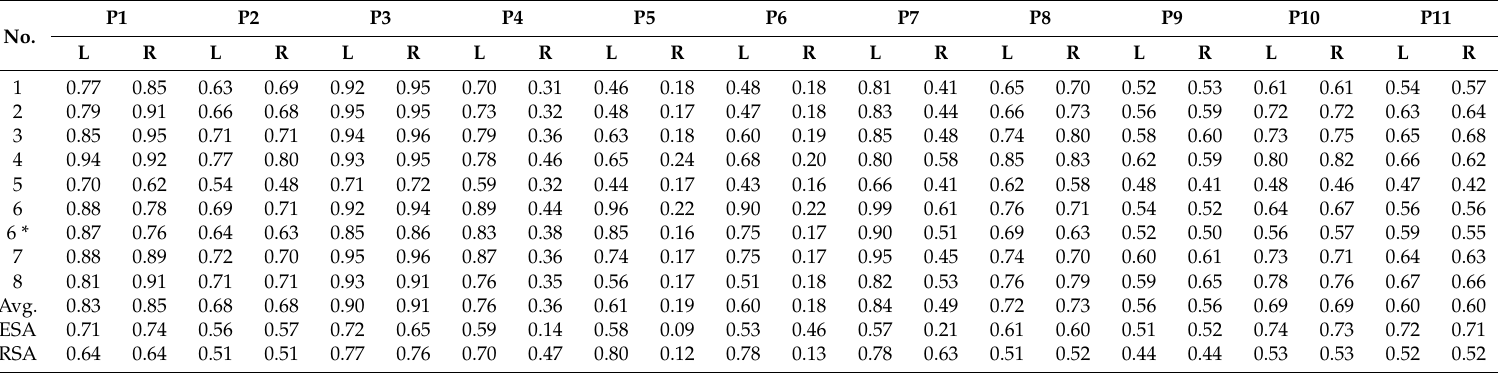
Table 6. Demand/Capacity Ratios for bridges under near-field earthquakes, Equivalent Static (ESA) and Response spectrum (RSA) analyses.